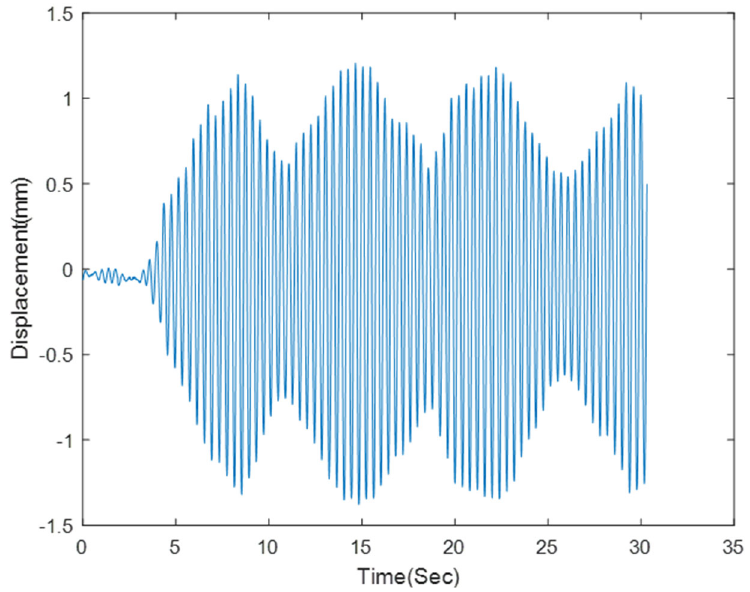
Figure 6. Test bridge’s displacement response collected by Polytec ground laser under: Human running on bridge.